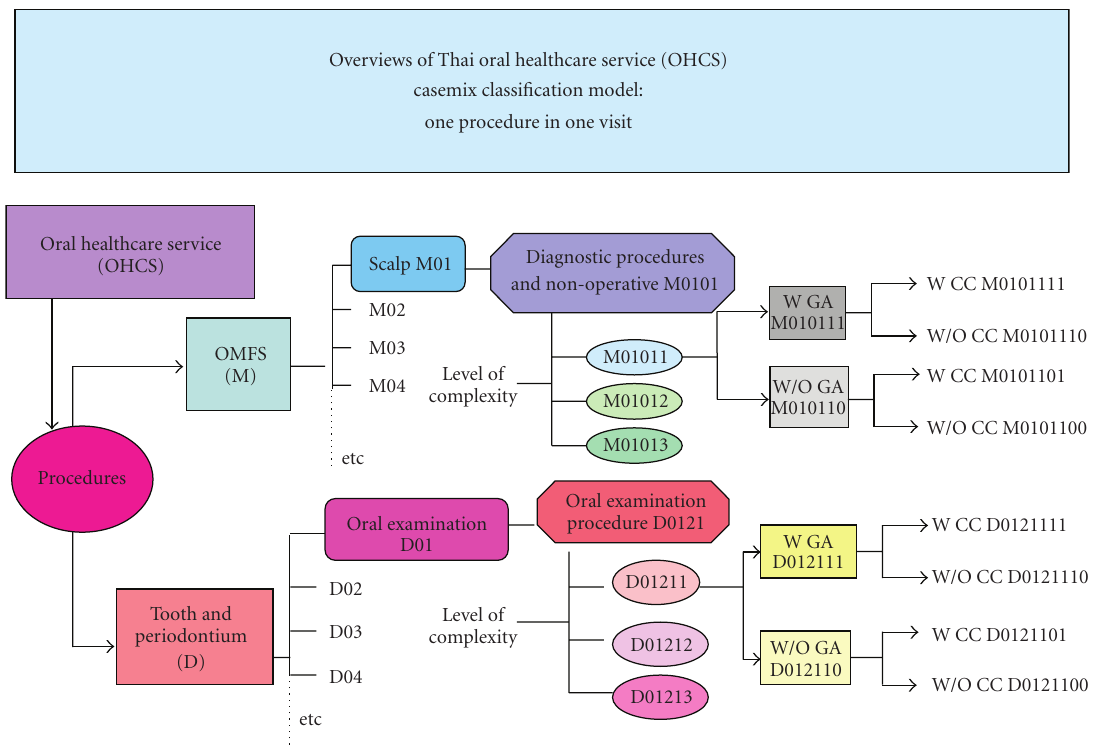
Figure 3: Diagram demonstrates the overviews of the Thai oral healthcare service (OHCS) casemix classification model of one procedure in one visit. M = oral and maxillofacial surgery (OMFS), W = with, W/O = without, GA = general anesthesia, CC = complication and comorbidity.